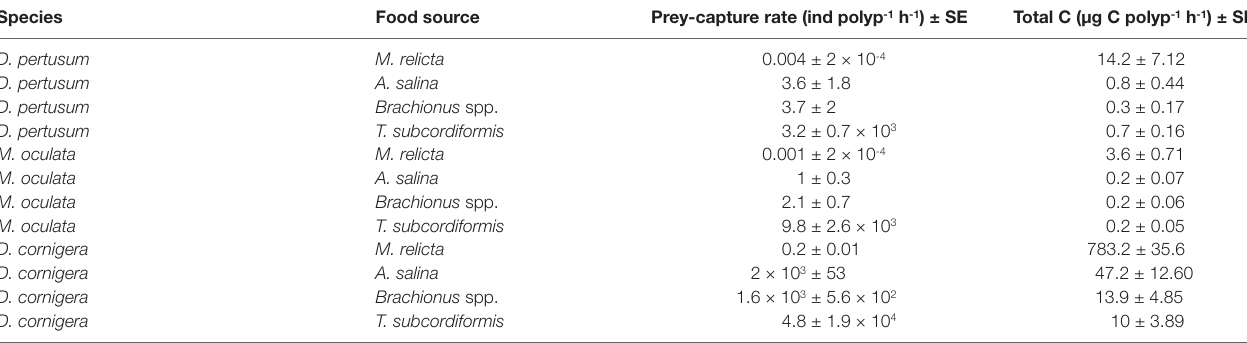
TABLE 4 | Different prey-capture rates of the three species of corals and total quantity of carbon captured per polyp. Species Food